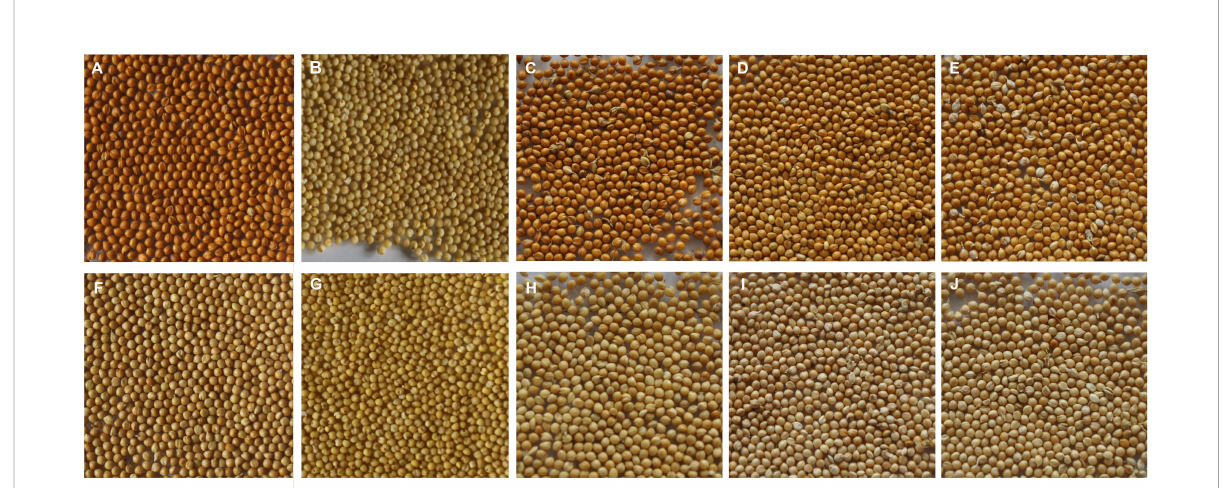
FIGURE 1 Phenotypic performances of hull and grain colors of foxtail millet cultivars Yugu 5 and Jigu 31 and the selected lines from the cross Yugu 5 × Jigu 31. (A, B) , brown hull color and yellow grain color of Jigu 31; (C – E) , brown hull color of selected lines; (F, G) , yellow hull and grain colors of Yugu 5; (H – J) , yellow hull color of selected